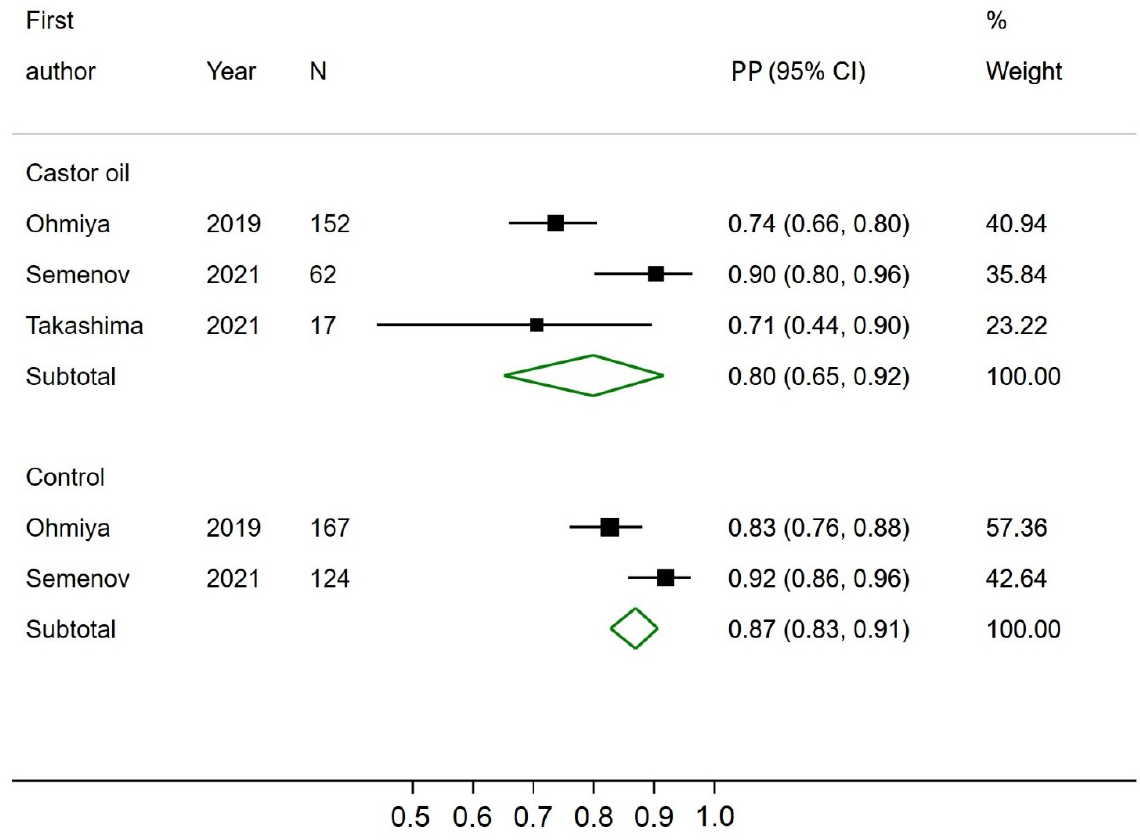
Figure 3. Forest plot of acceptable bowel preparation rates of colon capsule endoscopy using castor oil in the bowel preparation regimen and in the control groups. PP—Estimated prevalence proportion.